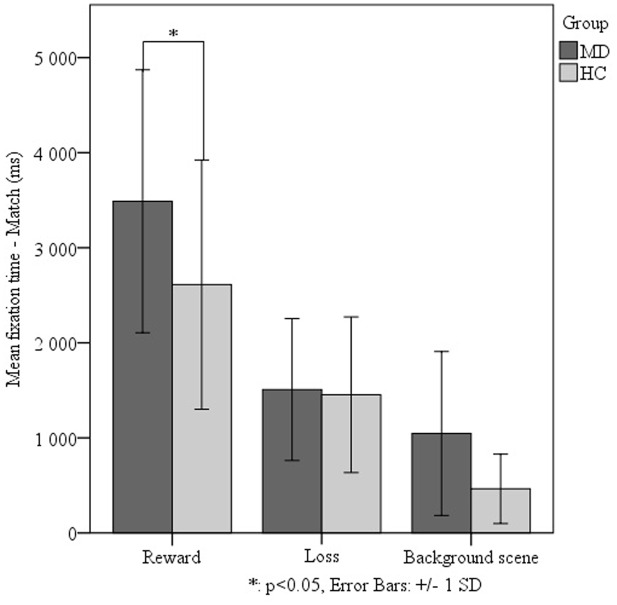
Effect of virtual monetary reward or loss on fixation durations comparing the MD and HC groups. In the Match condition – when relational memory information was present – we found MD patients to view faces associated with monetary reward for a significantly longer duration (M = 3489.05 ± 1382.788) than the HC group (t48 = 2.501, p = 0.016). This analysis was justified by higher order statistical analysis examining main effects of facial emotion and virtual reward or loss on relational memory performance.